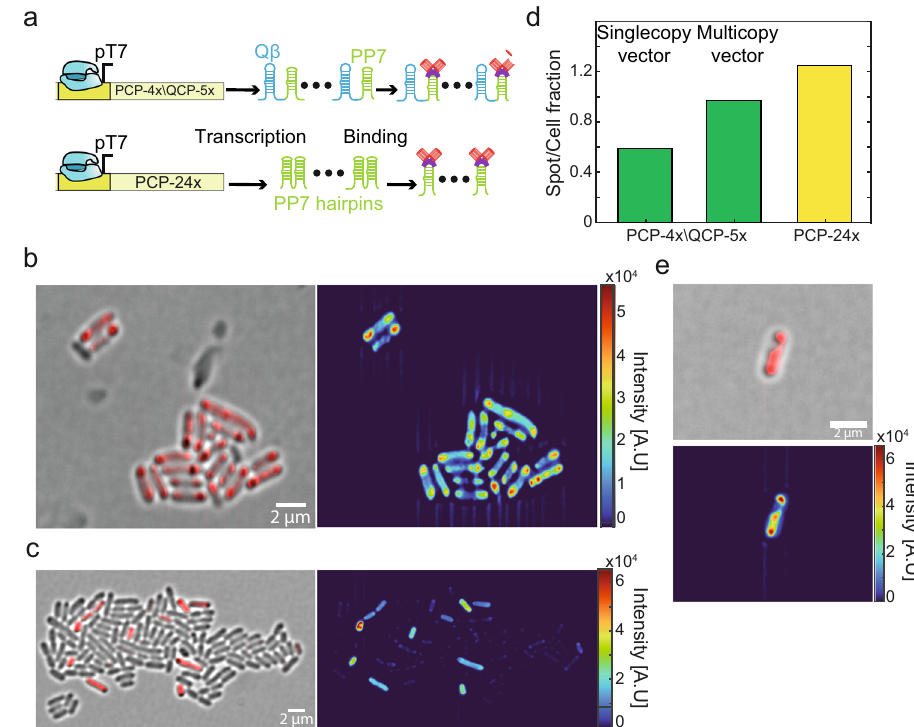
Fig. 6 | Synthetic phase separated condensates within bacterial cells. a ConstructdiagramdepictingexpressionofthetwoslncRNAcassettesusedinthe invivoexperiments,inthepresenceoftdPCP-mCherry. b (Left)Mergedstructured illumination bright fi eld-585 nm image of cell expressing the PCP-24x slncRNA togetherwithtdPCP-mCherry.(Right)Heatmapofthesameimageshowingahighly fl uorescent punctum as cell poles. Color bar indicates fl uorescence intensity. c (Left) Merged bright fi eld-585 nm image of cell expressing the negative control RNA together with tdPCP-mCherry. (Right) Heatmap of the same image showing a